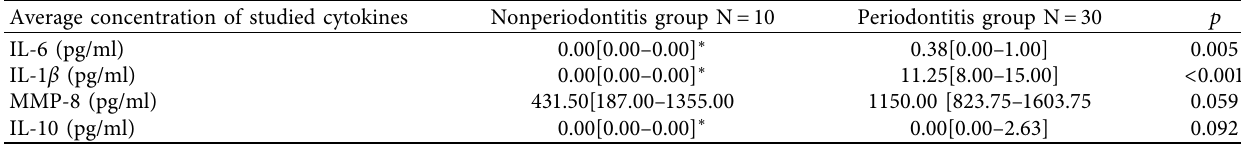
Table 2: Salivary levels of IL-6, IL-1 β , IL-10, and MMP8 in nonperiodontitis and periodontitis patients.